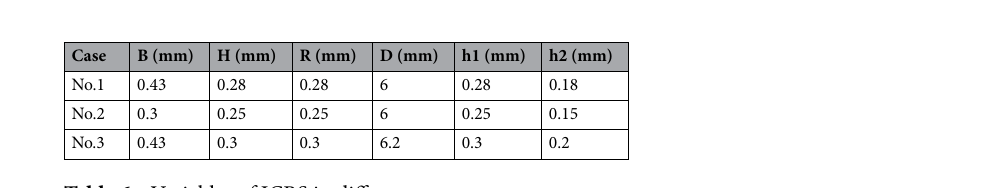
Table 6. Variables of ICRS in different